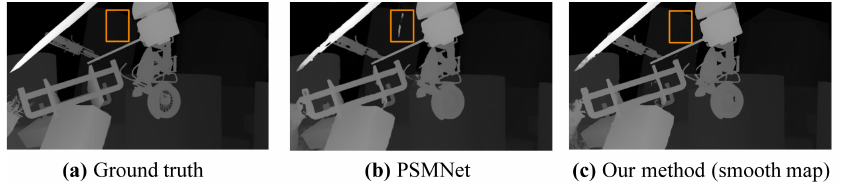
Figure 7. Qualitative result of adding smooth map as input. ( a ) is the ground truth, ( b ) is the result of baseline model, and ( c ) is the disparity result of our method with smooth